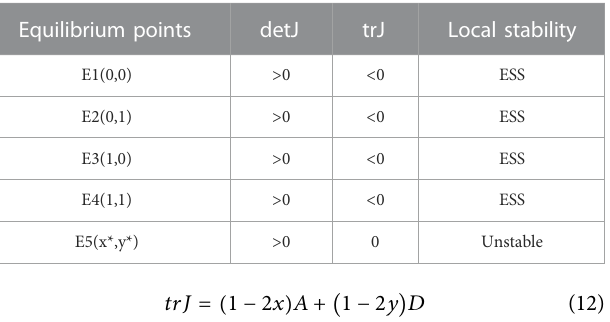
TABLE 3 Evolutionary stability strategies of replicator dynamics systems with different